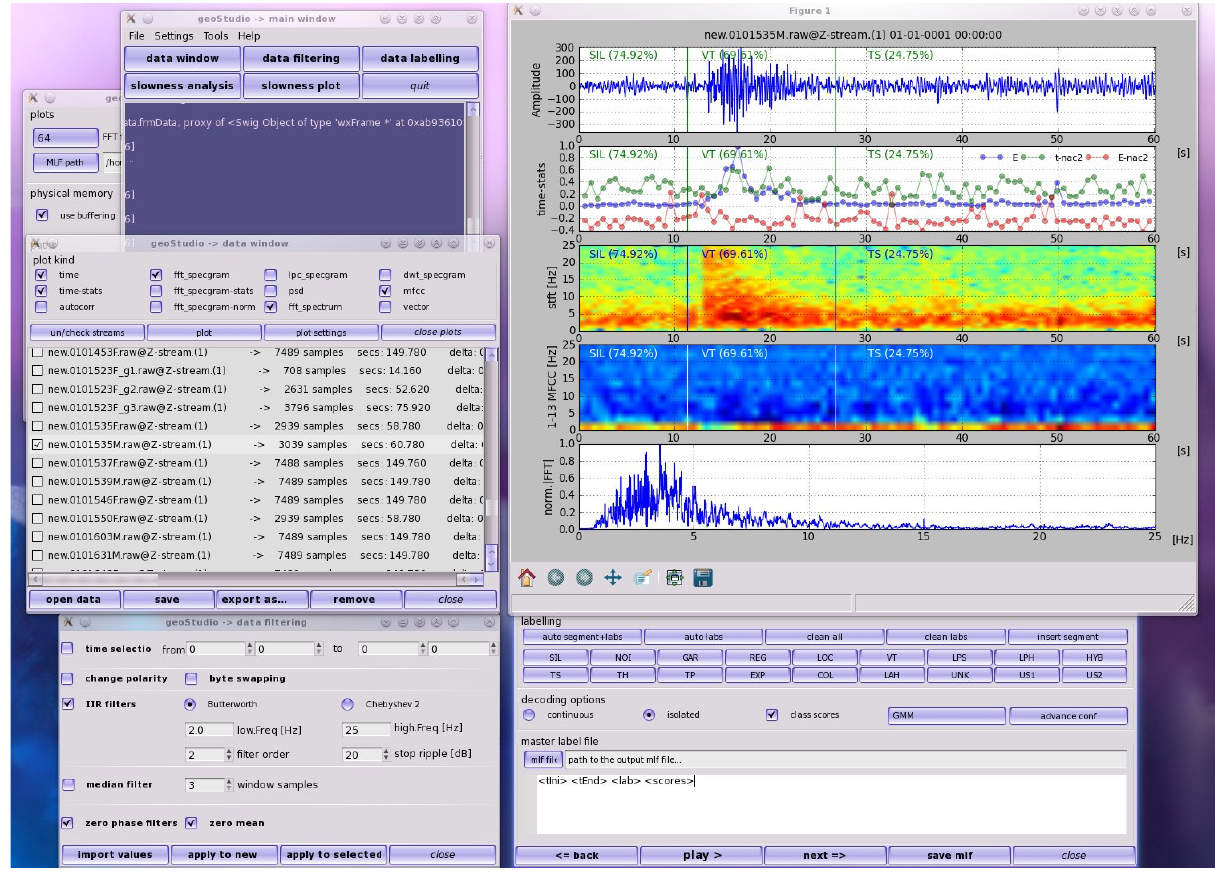
Figure 10. Screenshot of the software for the automatic signal recognition running under the GeoStudio